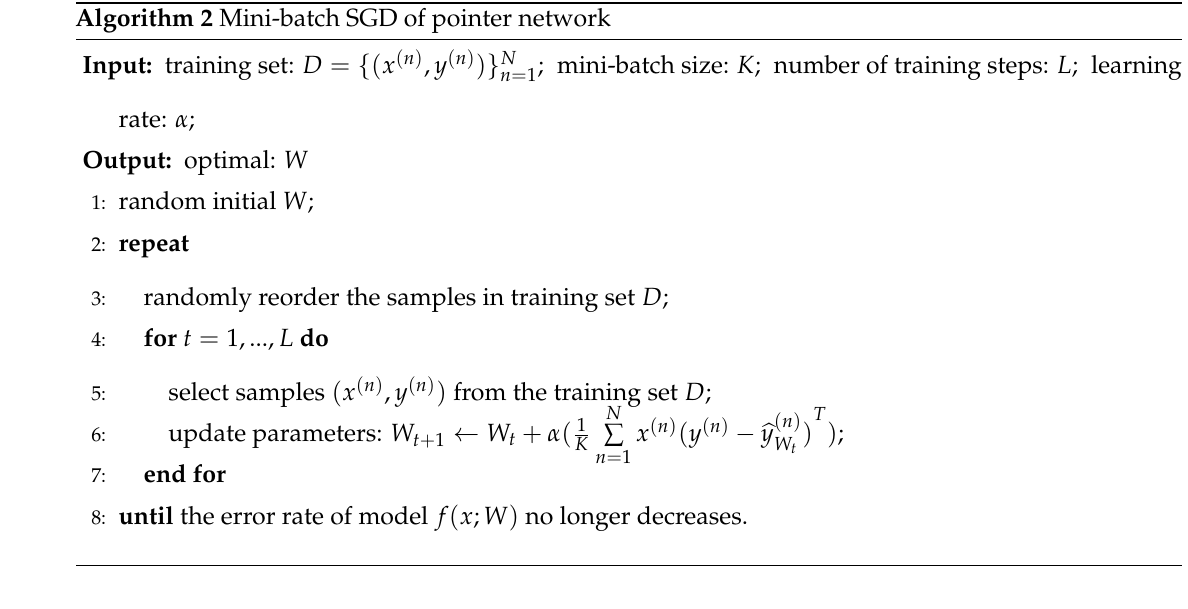
Algorithm 2 Mini-batch SGD of pointer